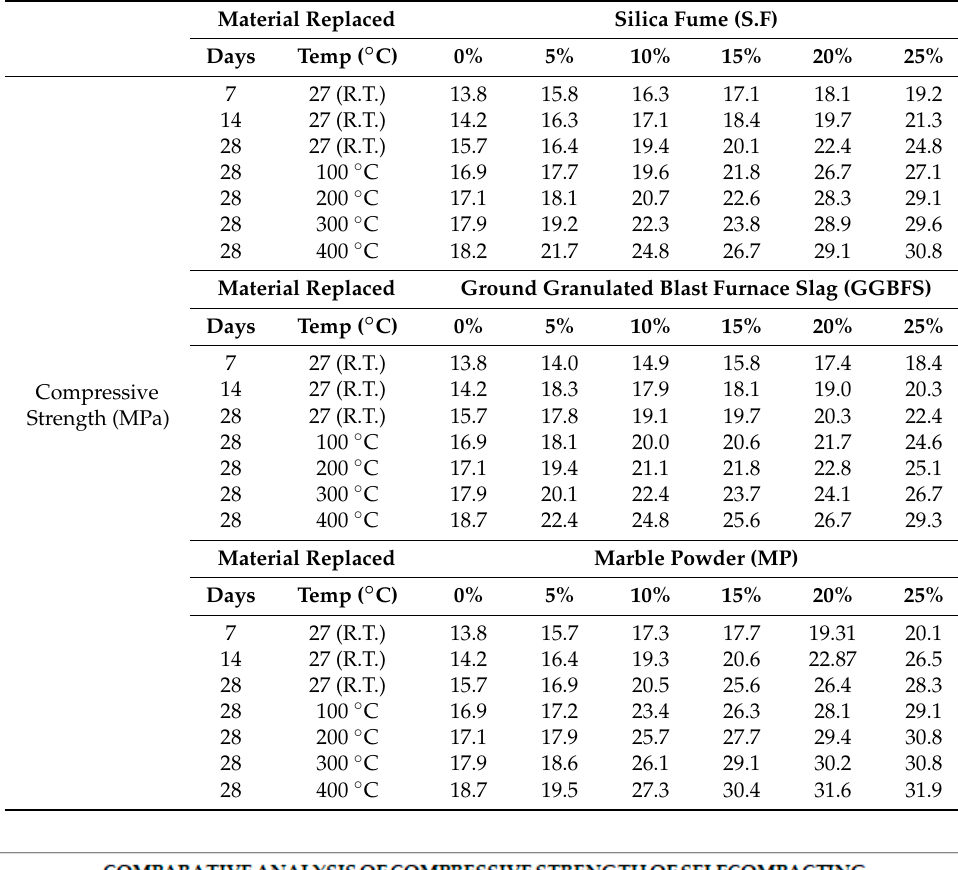
Table 4. Test Results for hardened self-compacted concrete (compressive strength, MPa).